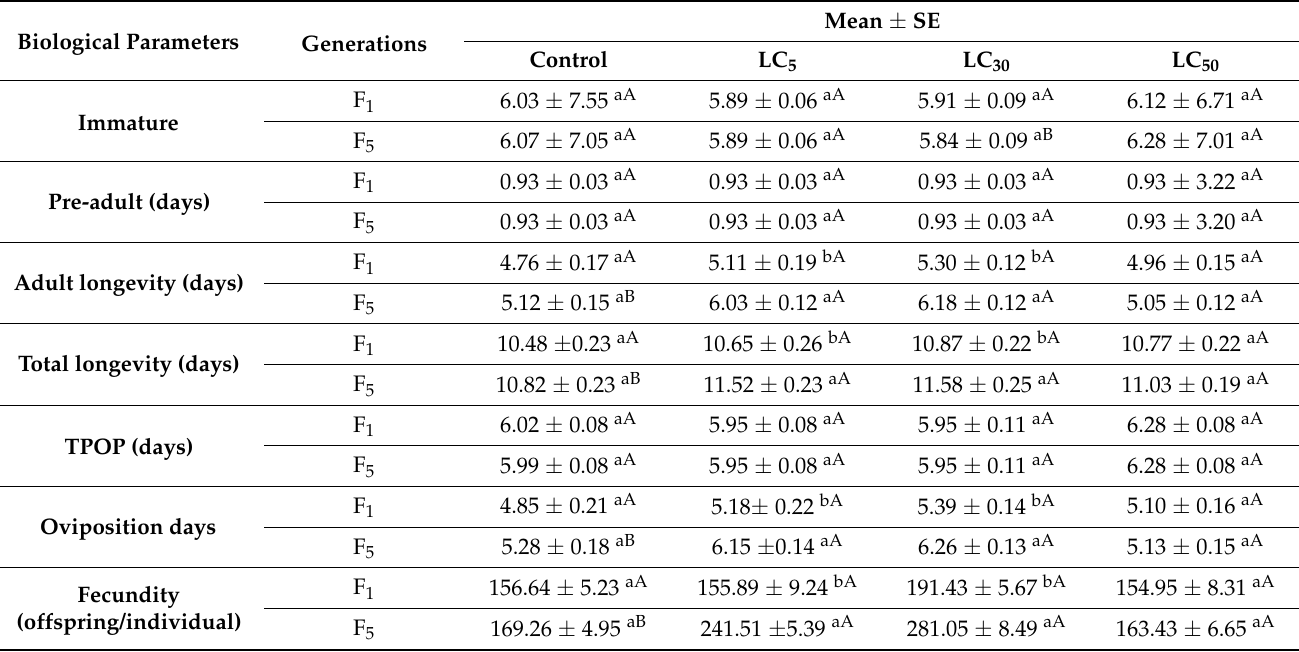
Table 2. Multigenerational effects of imidacloprid on the biological parameters of F 1 and F 5 genera- tions of T . chilonis